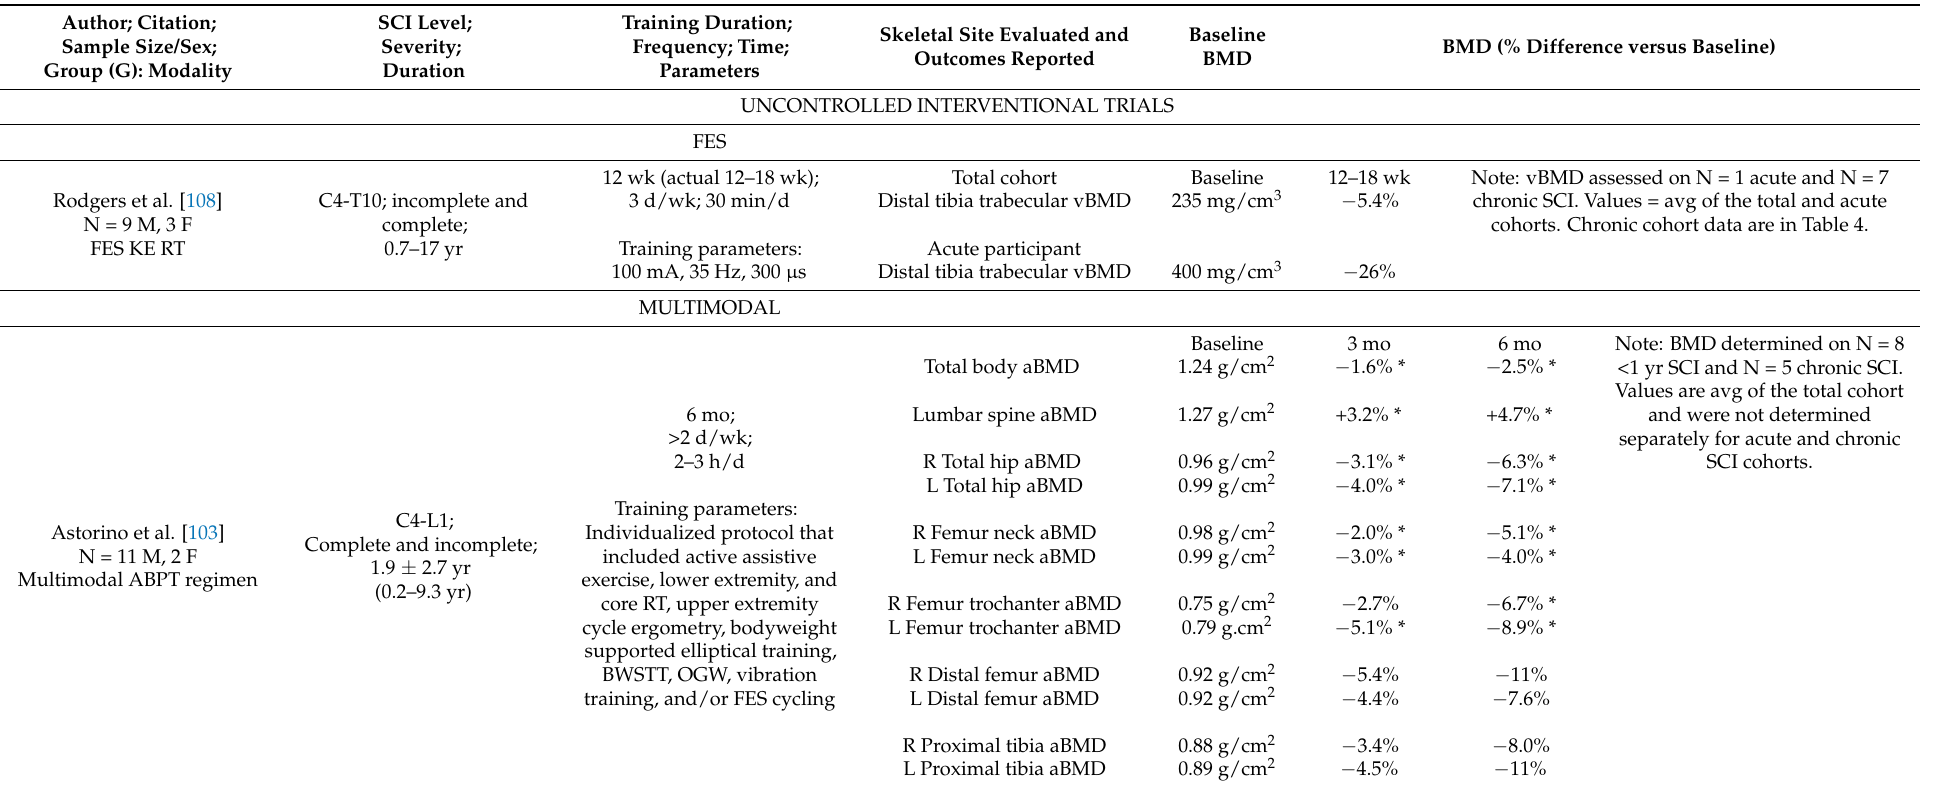
Table 2. Uncontrolled and controlled interventional studies evaluating the effects of activity-based physical therapy (ABPT) and/or loading on bone mineral density (BMD) in adults with acute or subacute spinal cord injury